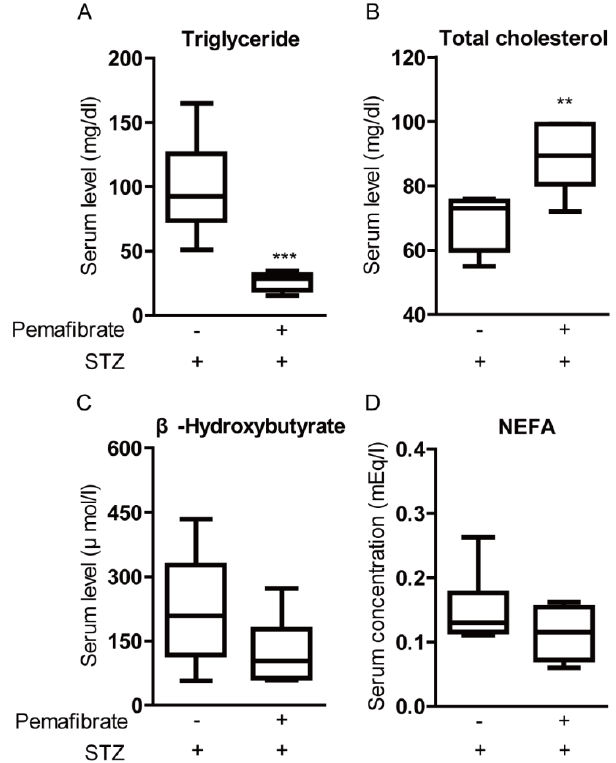
Figure 3. Change of lipid metabolism by pemafibrate in the STZ-induced diabetic mouse model. ( A ) Quantitative analysis showed that pemafibrate decreased serum triglyceride level in STZ-induced diabetic mice ( n = 6 per group). ( B ) Quantitative analysis showed that pemafibrate increased serum total cholesterol level in STZ-induced diabetic mice ( n = 6 per group). ( C , D ) There was no significant di ff erence in serum level of β -Hydroxybutyrate and concentration of NEFA between pemafibrate-administered mice ( n = 6) and vehicle-administered mice ( n = 6). ** p < 0.01, *** p < 0.001. Graphs are presented as median with interquartile range, the 25th and 75th percentile. The data were analyzed using Student’s Int. J. Mol. Sci. 2020 , 21 , x FOR PEER REVIEW t -test. NEFA; non-esterified fatty acids.